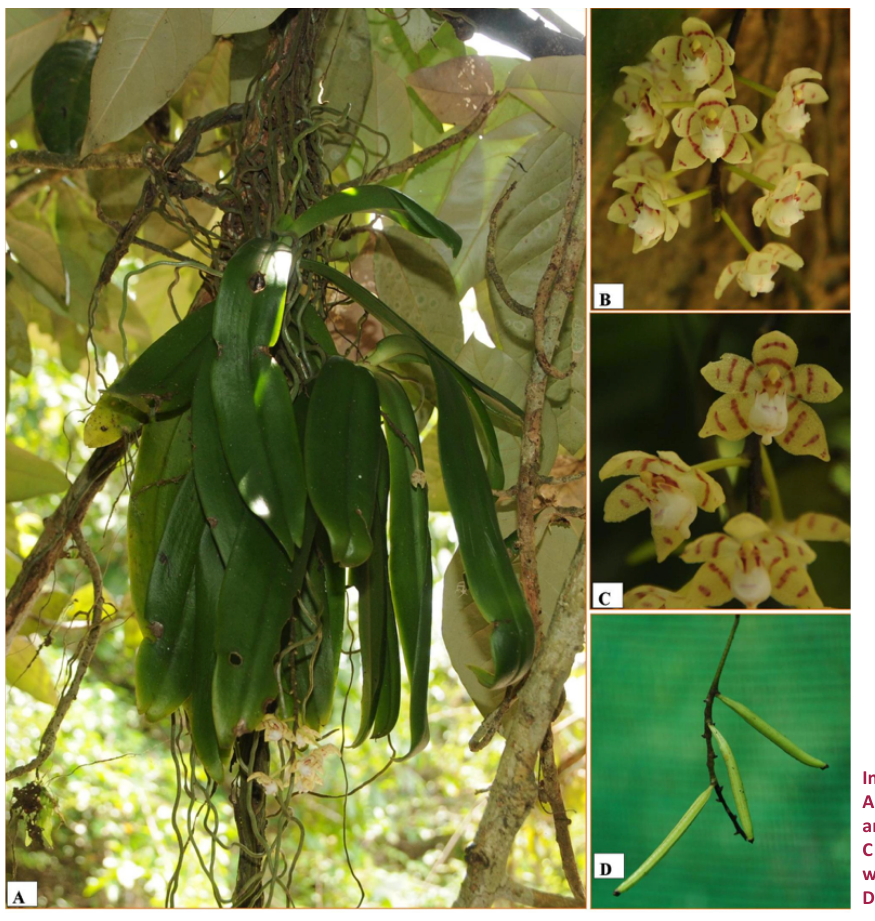
and petals with two spiral bands, C - flowers having sepals and petals with three to four spiral bands, D - capsules. © Sanjay